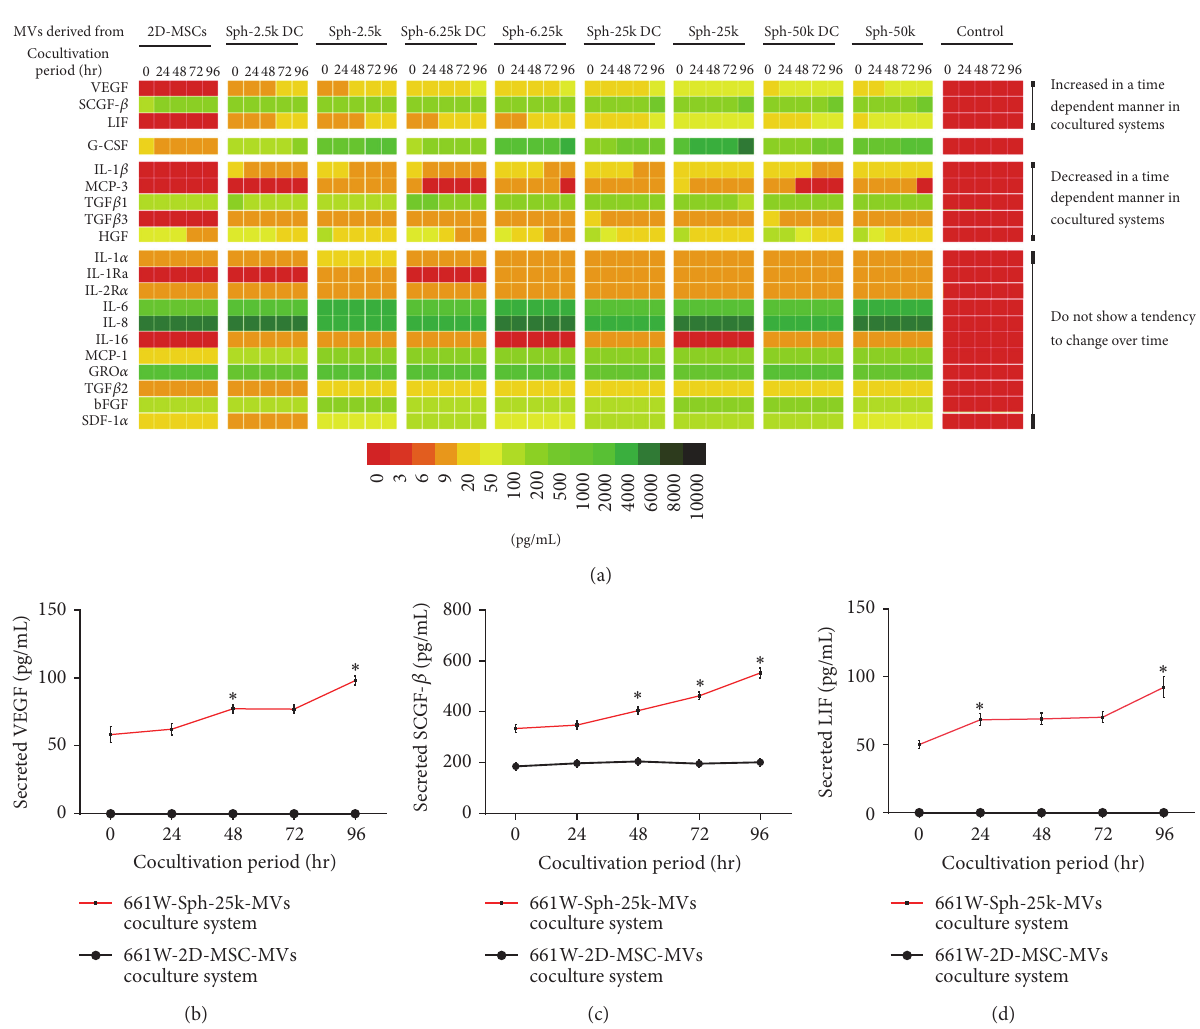
Figure 5: Heatmap of signal factor secretion by MVs derived from 2D-MSCs or 3D-MSCs cocultured with 661W cells. (a) 3D-MSC-MVs possessed enhanced capability of promoting signal factors secretion compared to 2D-MSC-MVs. SCGF- 𝛽 , VEGF, and LIF expression levels are increased in a time dependent manner in supernatants from 661W-3D-MSC-MVs cocultured systems (b, c, d). ∗ denotes significant differences of 𝑝 value less than